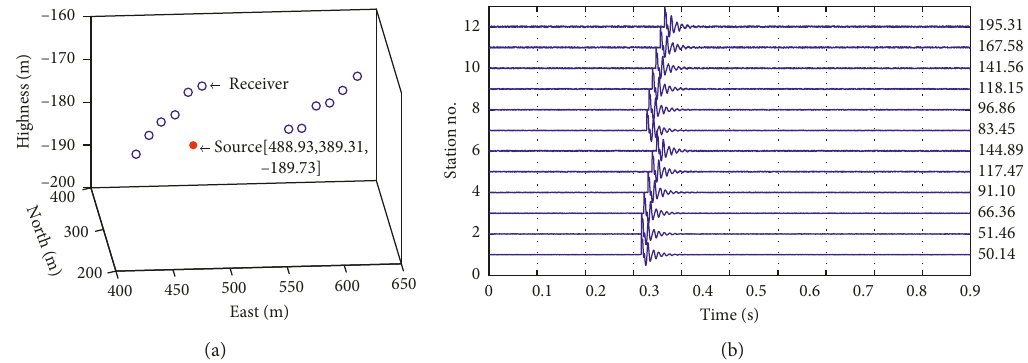
Figure 4: Model and survey diagram and receiving records of monitoring network. (a) Model and survey diagram. (b) Receiving records of monitoring network.